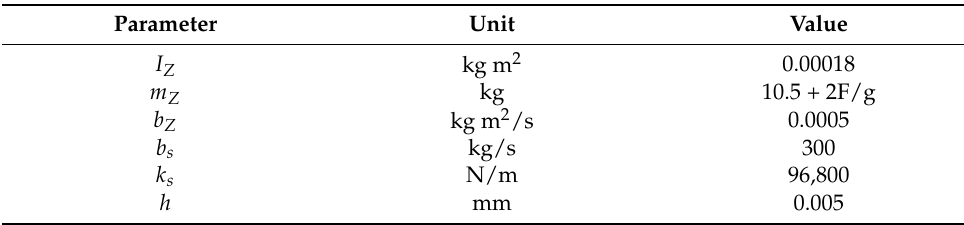
Table 1. Model parameters applied during simulation and experimental tests.